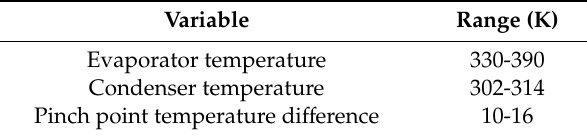
Table 4. Optimization variables changing